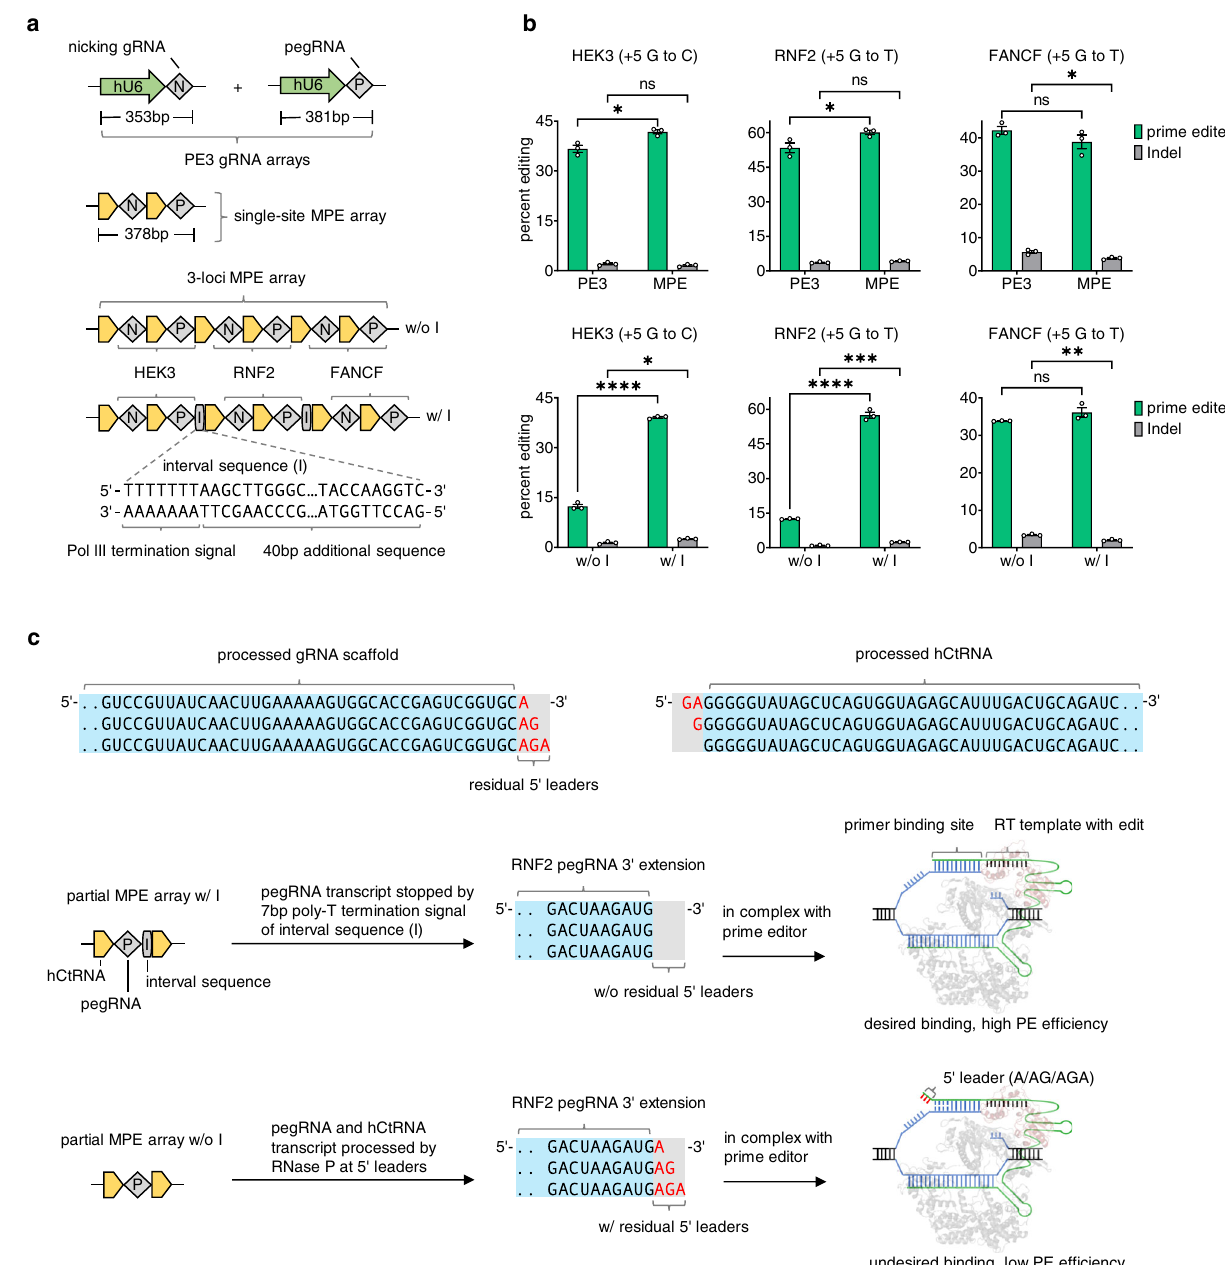
Fig. 4 MPE with DAP arrays. a Schematic of MPE development. The size of PE3 gRNA arrays and single-site MPE array were compared using gRNA sequences designed for RNF2 ( + 5G to T). b Ef fi cient single-site and 3-loci MPE. The w/o I and w/ I arrays were compared for 3-loci MPE. c Schematic illustration of the observed low 3-loci MPE ef fi ciency (w/o I) in b . After the endogenous processing of the MPE array without interval sequence (w/o I), partial or complete 5 ′ leader sequences will remain at the 3 ′ end of pegRNA, which causes undesired primer binding and decreases the PE ef fi ciencies. By adding the interval sequence (w/ I) at the 3 ′ end of pegRNA, the poly-T termination signal will isolate the original 3 ′ end of pegRNA from additional sequences, achieving desired binding and expected PE ef fi ciencies. All tests were performed in HEK293T cells and analyzed using NGS. Detailed protospacers, edited bases, amplicons, primers, and plasmid maps of the relevant fi gures are available in Supplementary Tables 1 and 5. Error bars in b represent mean ± s.e.m. from n = 3 replicates (unpaired two-tailed t -test; ns not signi fi cant; * P < 0.05; ** P < 0.01; *** P < 0.001; **** P < 0.0001). P = 0.0146 (prime edited value comparison between MPE and PE3 for HEK3 ( + 5G to C)). P = 0.0444 (prime edited value comparison between MPE and PE3 for RNF2 ( + 5G to T)). P = 0.0166 (Indel value comparison between MPE and PE3 for FANCF ( + 5G to T)). P = 1.87E-06 (prime edited value comparison between w/o I and w/ I for HEK3 ( + 5G to C)). P = 0.0113 (Indel value comparion between w/o I and w/ I for HEK3 ( + 5G to C)). P = 4.44E − 06 (prime edited value comparison between w/o I and w/ I for RNF2 ( + 5G to T)). P = 0.0006 (Indel value comparison between w/o I and w/ I for RNF2 ( + 5G to T)). P = 0.002 (Indel value comparison between w/o I and w/ I for FANCF ( + 5G to